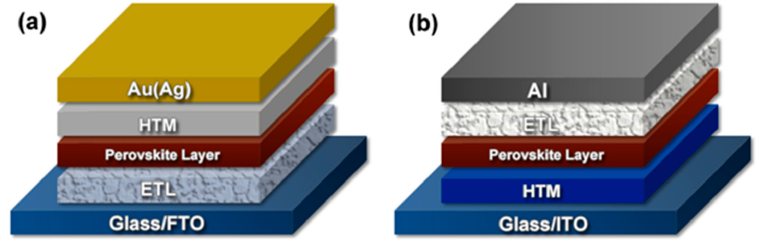
Figure 1. Structure of PVSK solar cells: ( a ) conventional device and ( b ) inverted device.